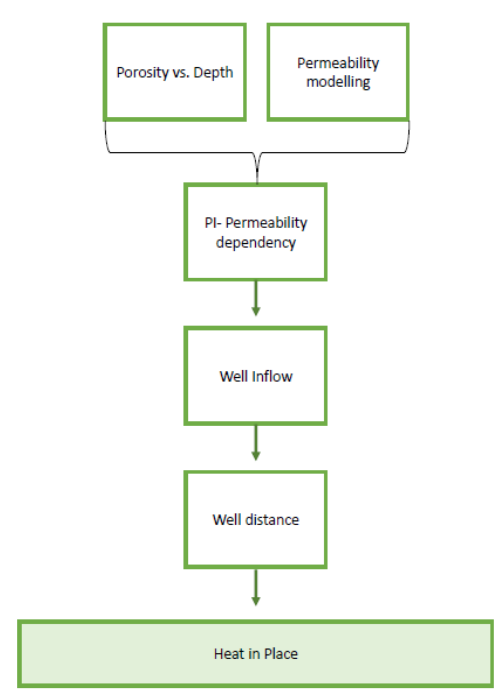
Figure 6. Calculation of heat-in-place flow chart.